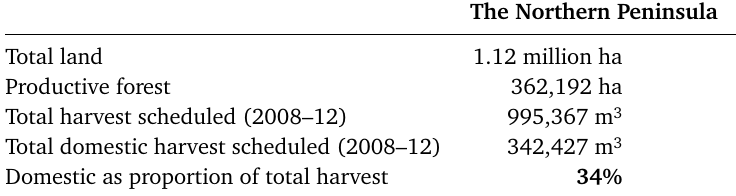
Table 2 Timber harvest information for the Northern Peninsula of Newfoundland